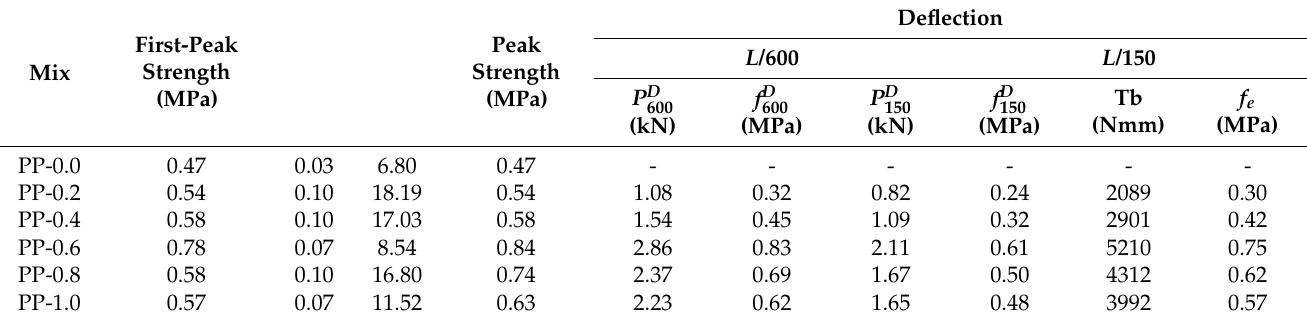
Table 8. Flexural properties (average of five specimens for each mix